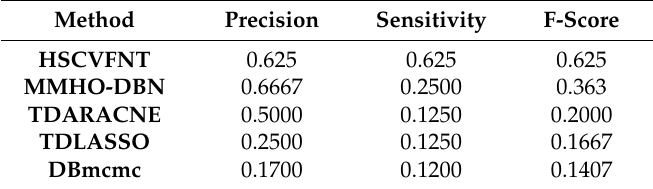
Table 3. Comparison of five methods for IRMA network inference with off